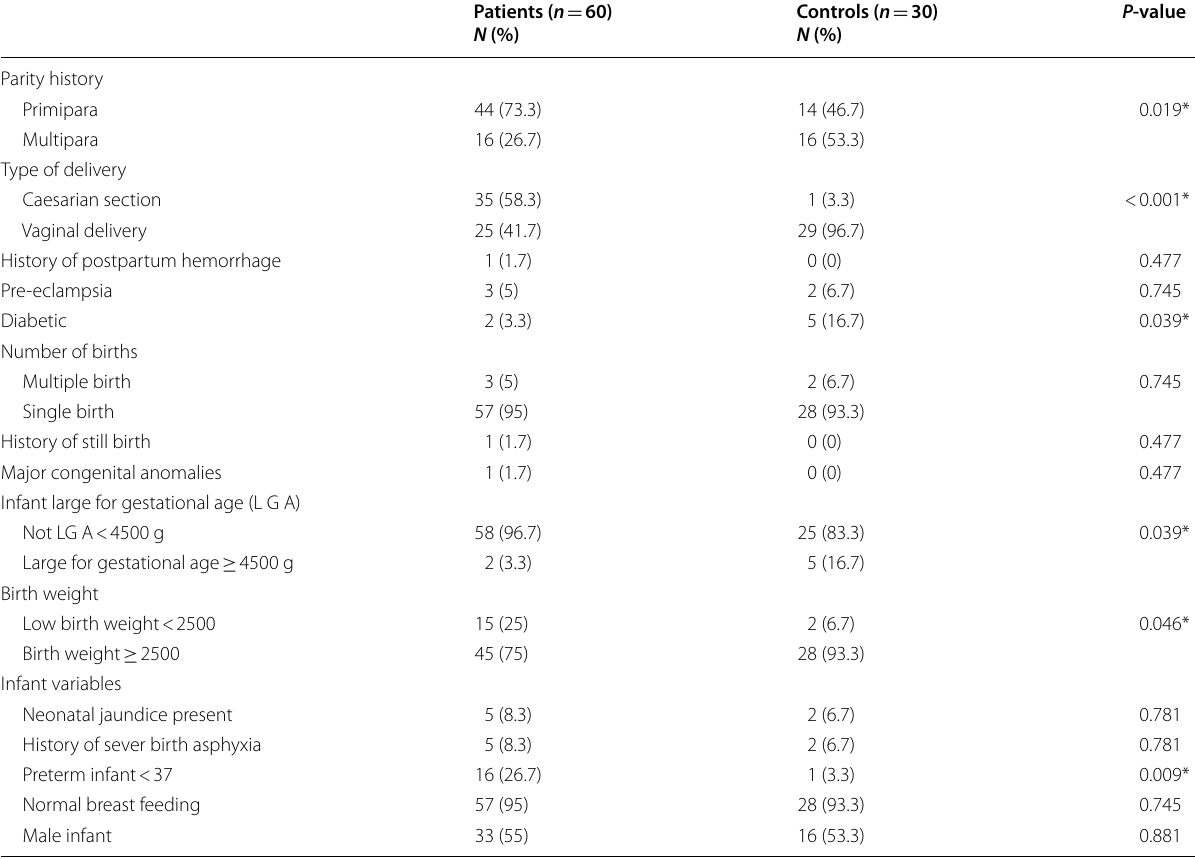
Table 2 Obstetric history among studied groups